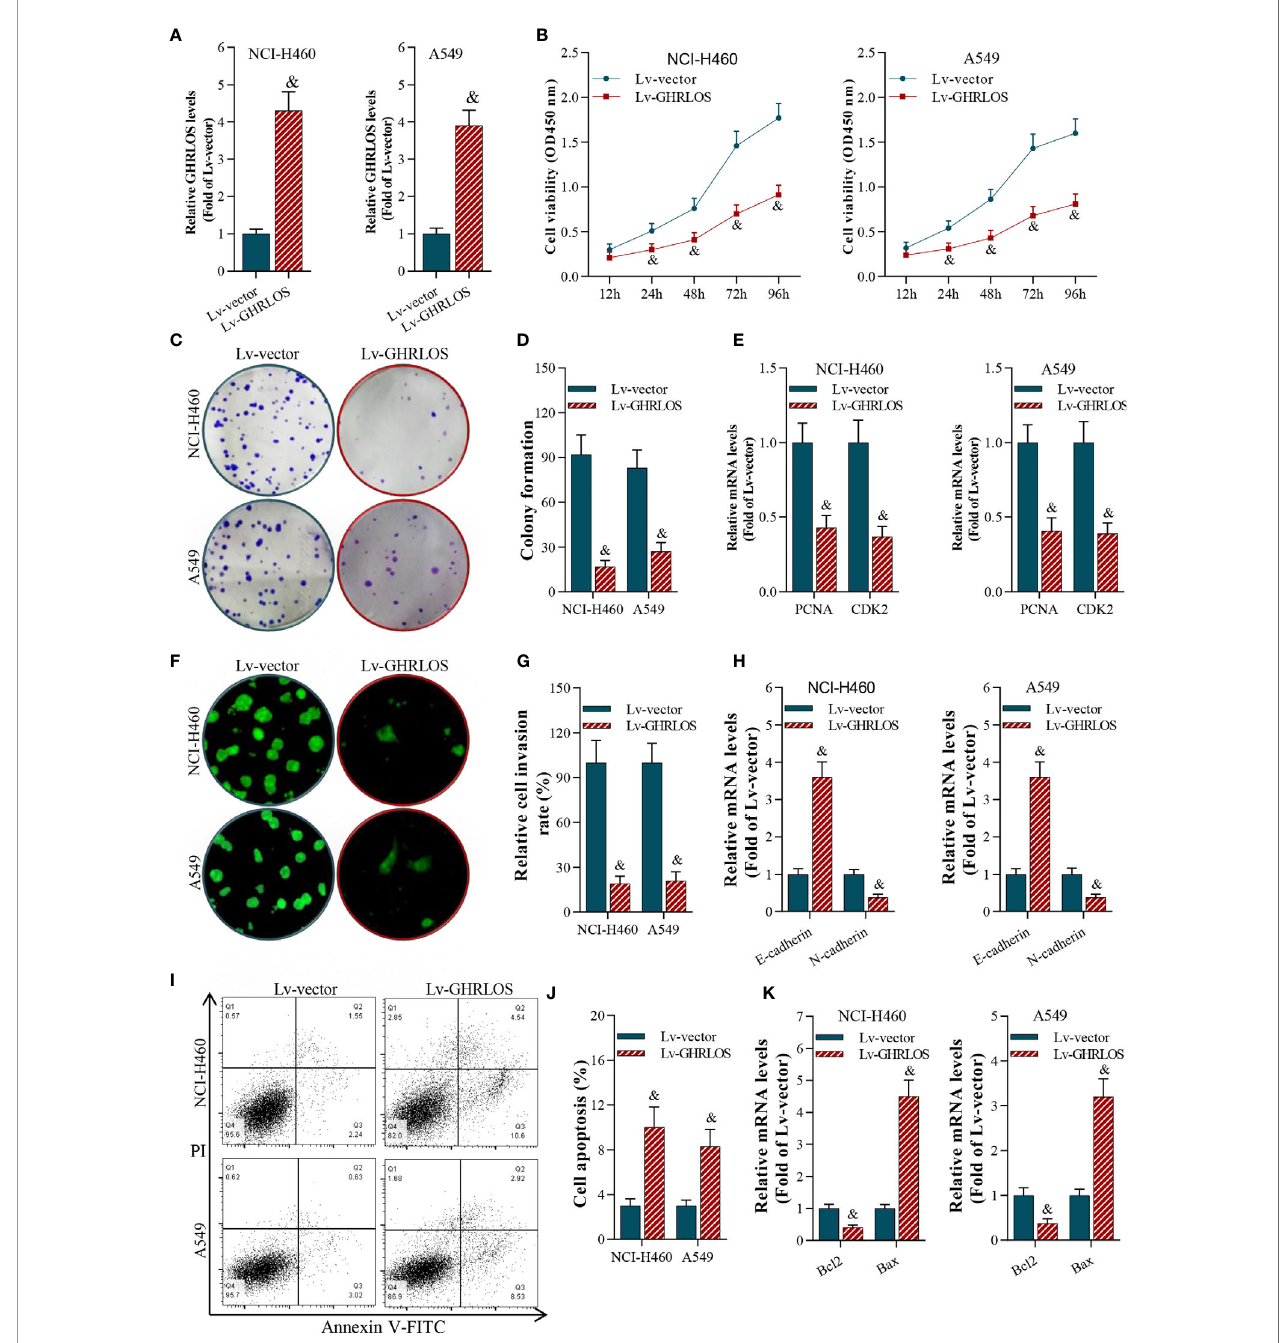
FIGURE 2 | LncRNA GHRLOS inhibited NSCLC cell growth and invasion, and increased apoptosis. (A) qRT-PCR determination on lentivirus-induced overexpression of lncRNA GHRLOS at 48 h in A549 and NCI-H460 cells, &p< 0.01 vs. Lv-vector. (B) CCK-8 assay on the effect of lncRNA GHRLOS on cancer cell proliferation after lentivirus infection at the indicated time points, &p< 0.01 vs. Lv-vector. (C, D) Colony formation assay on the effect of lncRNA GHRLOS on growth of cancer cells after 14 days of culture, &p< 0.01 vs. Lv-vector. (E) qRT-PCR analysis on the expression of cell growth-associated genes, PCNA and CDK2, in A549 and NCI-H460 cells after overexpressed lncRNA GHRLOS for 48 h, &p< 0.01 vs. Lv-vector. (F, G) Trans-well assay analysis on the effect of lncRNA GHRLOS on the invasion of cancer cells, &p< 0.01 vs. Lv-vector. (H) qRT-PCR analysis on cell adhesion-related genes, including E-cadherin and N-cadherin, in A549 and NCI-H460 cells after infection for 48 h, &p< 0.01 vs. Lv-vector. (I, J) Annexin V-FITC/PI analysis on the effect of lncRNA GHRLOS on cancer cell apoptosis, &p< 0.01 vs. Lv-vector. (K) qRT-PCR analysis on the expression of cell apoptosis related genes, Bax and Bcl-2, in NSCLC cells infected by lentivirus for 48 h, &p< 0.01 vs.